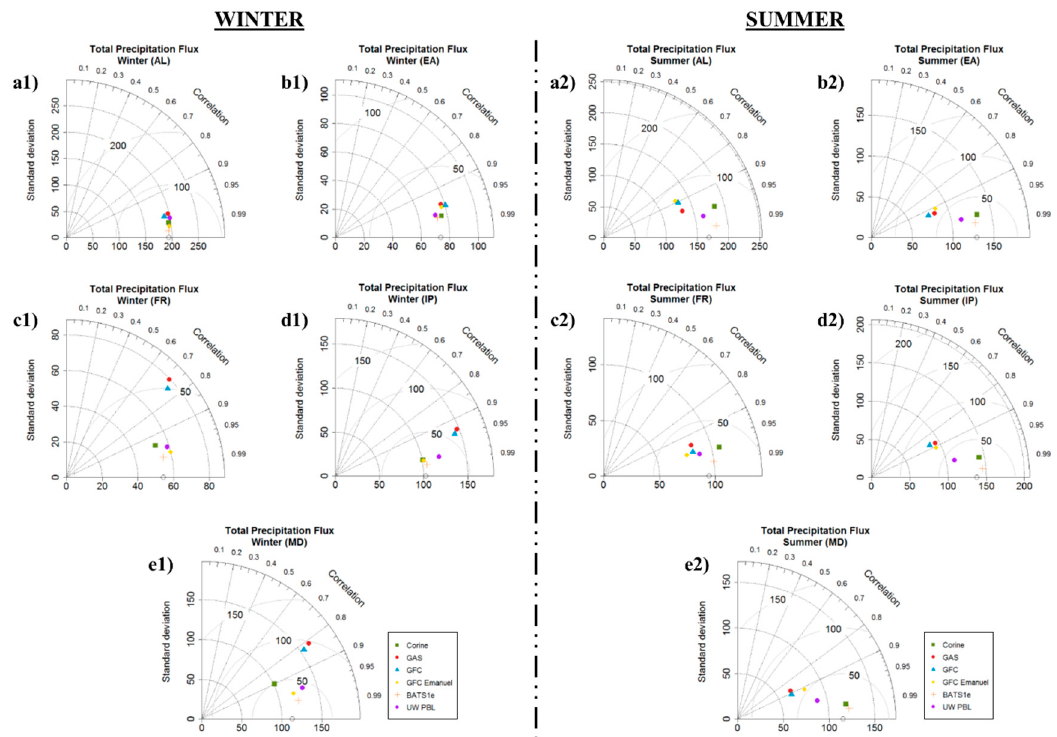
Figure 4. Taylor diagrams exploring the model’s performance for total precipitation over the five sub- regions (a → AL, b → EA, c → FR, d → IP, e → MD) during winter and summer. The markers in Taylor diagrams represent the different simulations. The default simulation is being used as reference field.